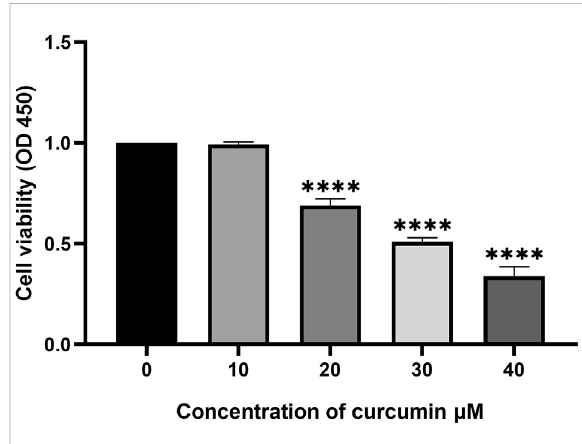
FIGURE 5 Study of cytotoxicity by using CCK-8 assay. The SK-MEL- 1cellsweretreatedwith curcumin indifferentconcentrations.The cell proliferation was signi fi cantly decreased under the